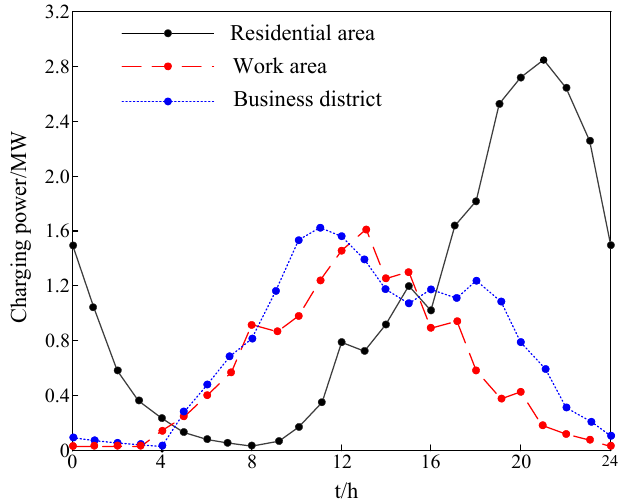
Figure 5. Charging load curve for different functional areas.